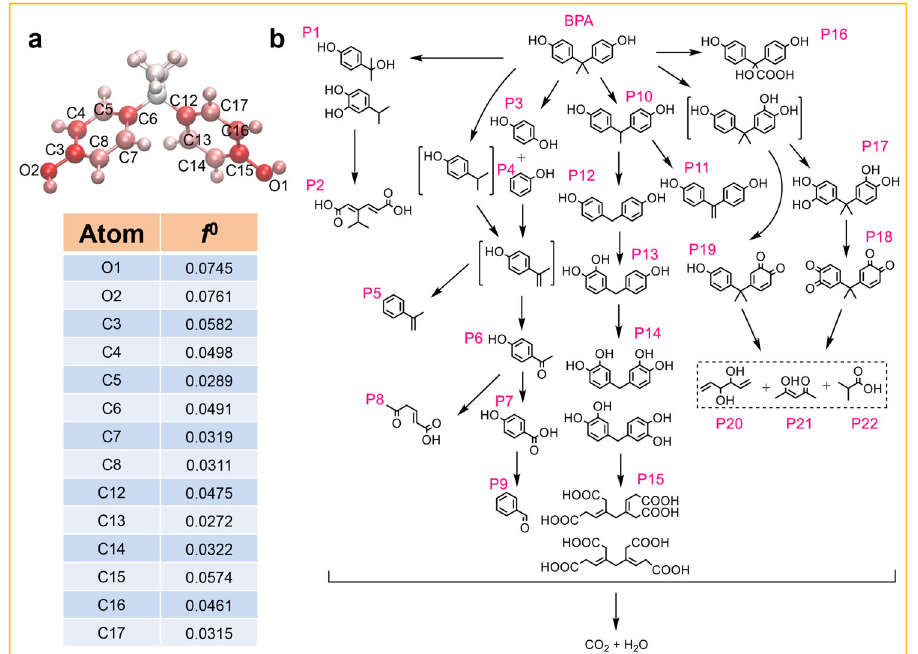
Fig. 6 The degradation and transformation mechanism of bisphenol A (BPA). a The condensed Fukui function of BPA based on density functional theory (DFT) calculation. b Transformation pathways for BPA in Mo 2 C MXene/peroxymonosulfate (PMS) system. f 0 is the speci fi c condensed Fukui function